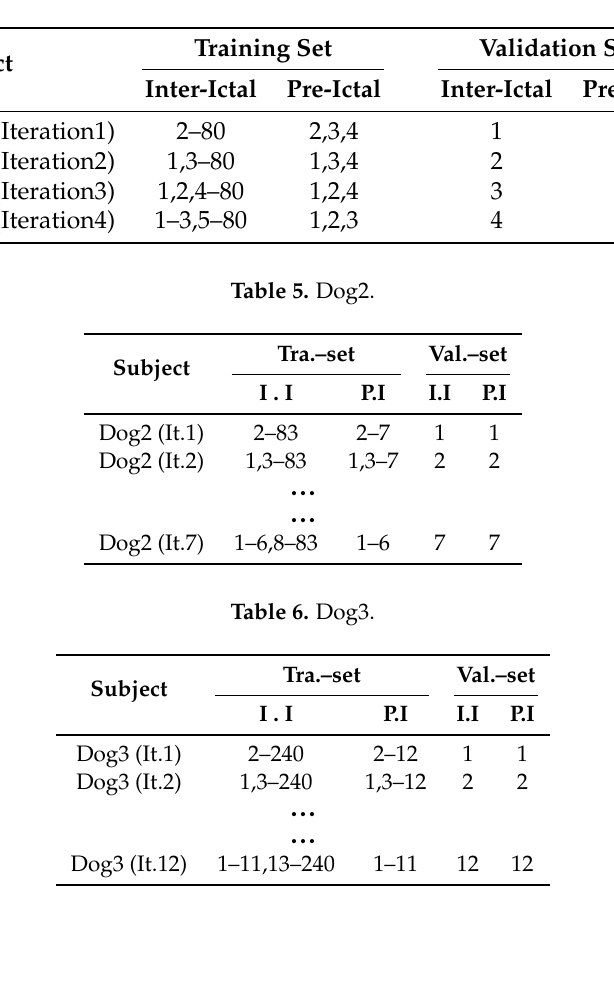
Table 4. Separation of 1 h blocks of data for a fair training and validation for Dog1. Each number represents the sequence number of the 1 h blocks [25]. Tables 5–10 present the separation of 1 h blocks of data for each subject. However, all iterations are not shown due to their